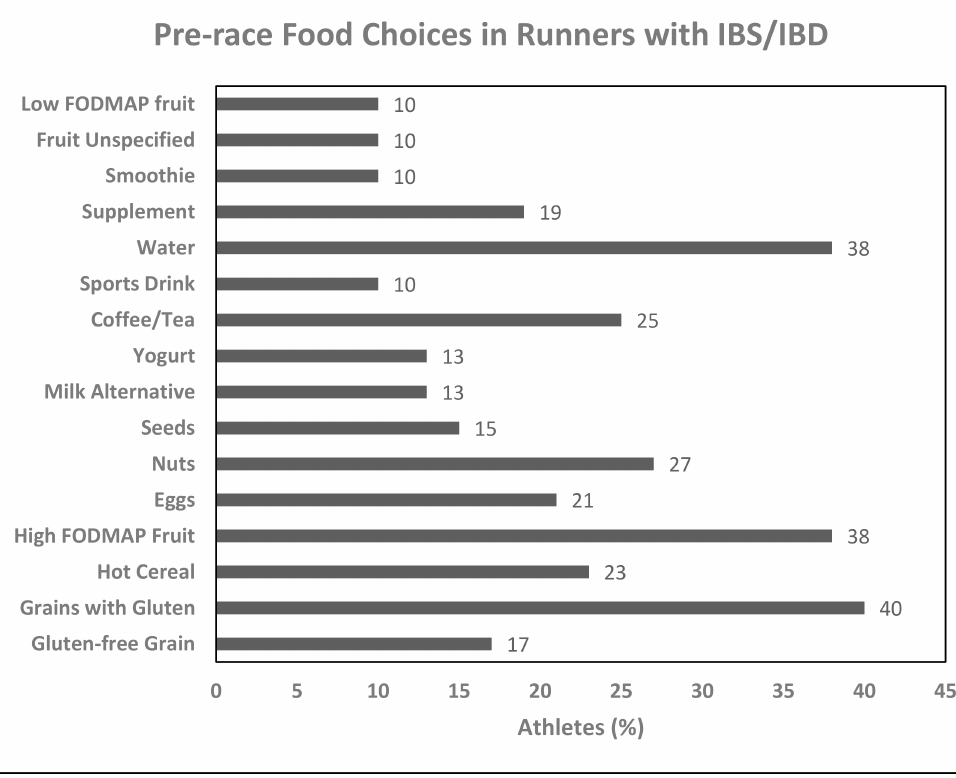
Figure 1. Commonly consumed foods pre-race for runners with